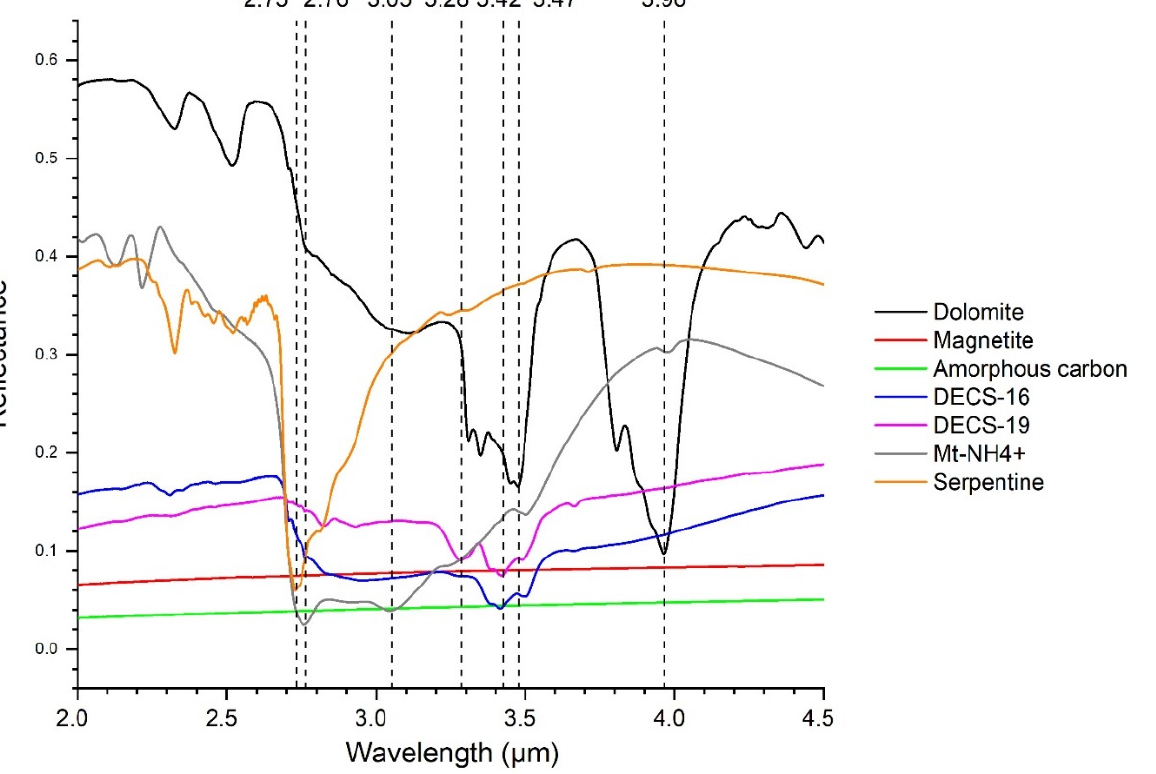
Figure 3. Reflectance spectra of the end-members used in this study between 2.0 and 4.5 µ m. Vertical dashed lines point at major bands for each sample that also correspond to major bands observed in Ceres’ spectra; 2.73–2.76 µ m: stretching OH from hydroxyl groups in phyllosilicate; 3.05 µ m: stretching NH from ammonium ions NH 4 + ; 3.28 µ m: stretching CH from aromatic carbon groups; 3.42 µm: stretching CH from aliphatic carbon group; 3.96 stretching CO 3 from carbonates.